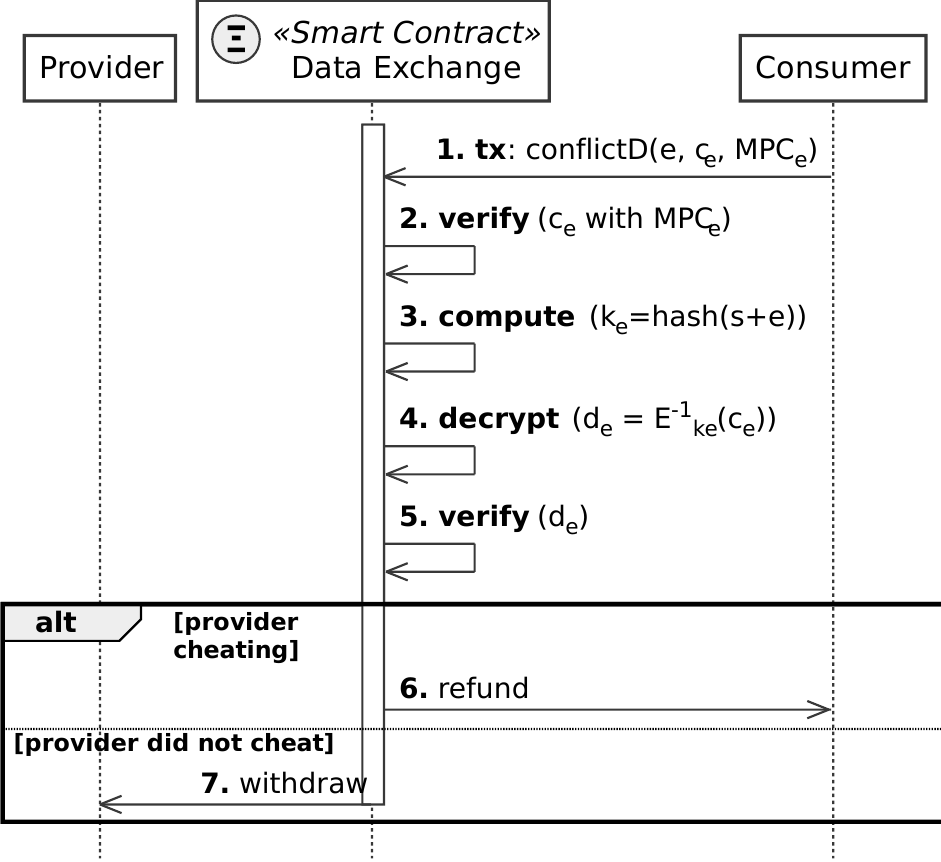
Figure 8. Protocol resolution-d: sequence